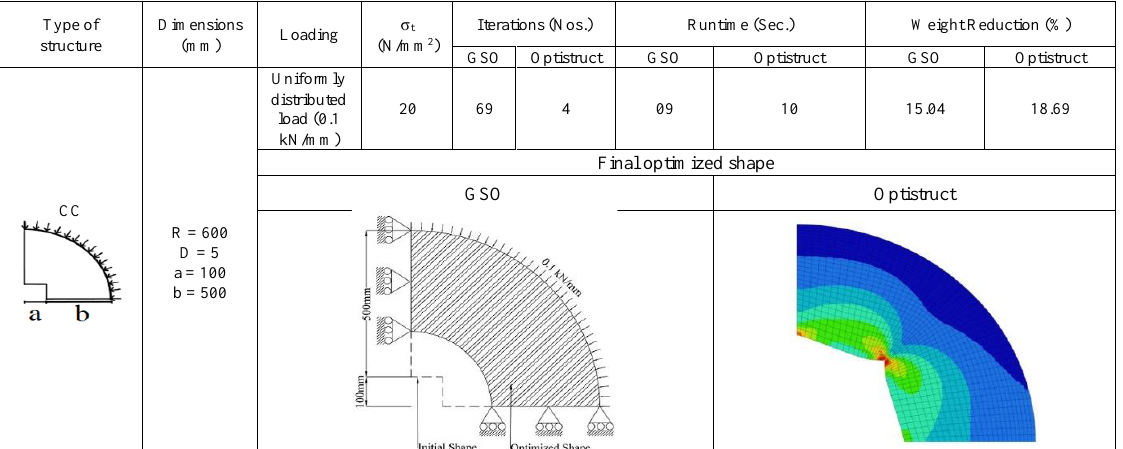
Table 3. Parameters for CC with iterations, runtime and percentage weight reduction to reach the optimized